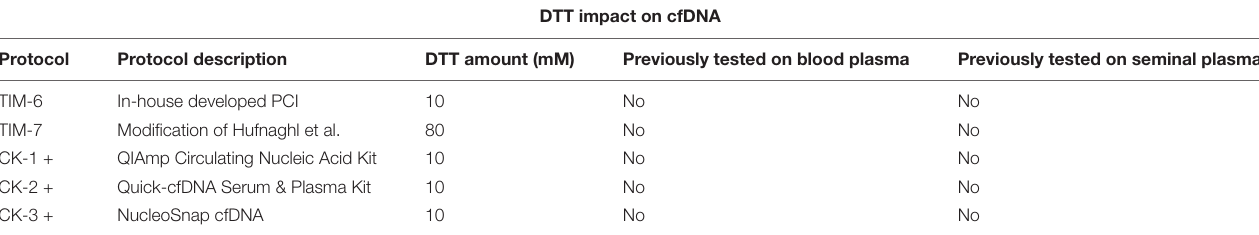
TABLE 3 | List of methods used to assess the impact of DTT addition on blood and seminal plasma isolation.